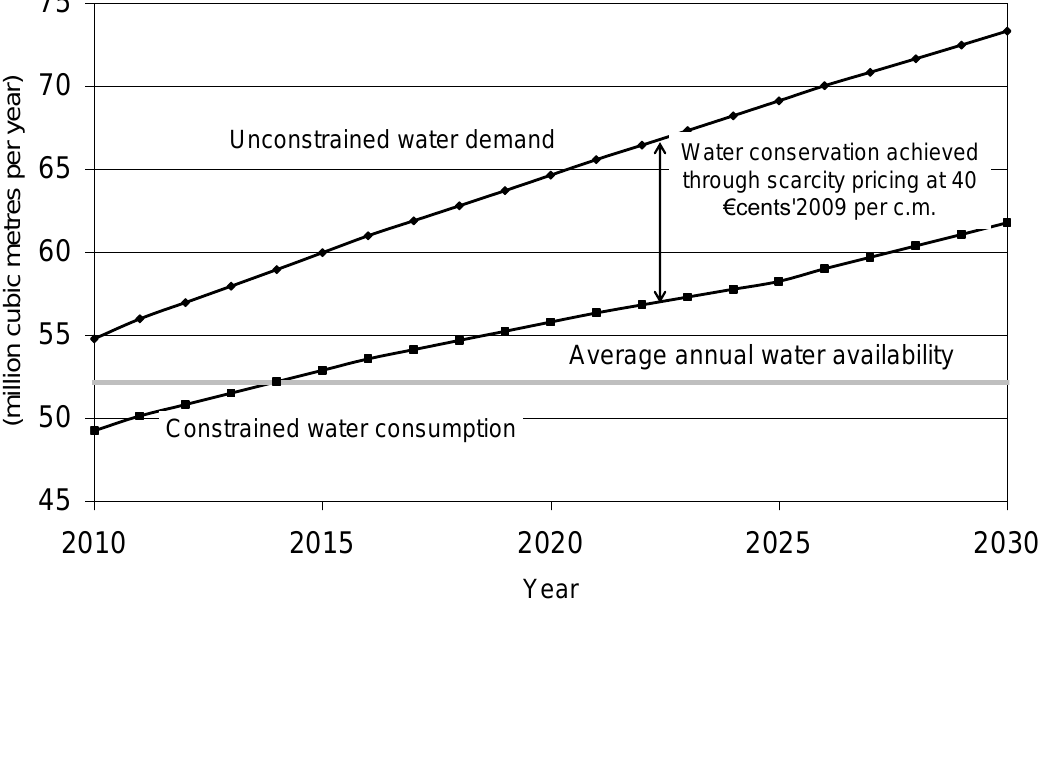
Figure 3. Evolution of optimal water consumption quantities throughout the period 2010–2030 according to scenario 2, at a price elasticity of −0.3. Note: Annual water availability takes into account the existing desalination plants of Dekelia and Larnaca, without their capacity expansions that became operational in